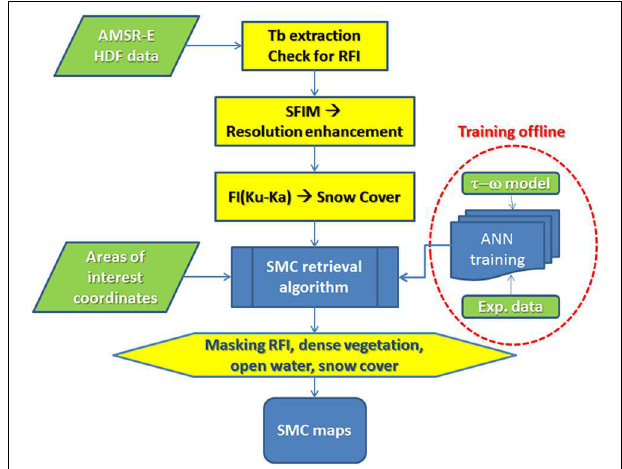
FIGURE 1 | Schematic representation of the HydroAlgo retrieval algorithm. HydroAlgo is based on an Artificial Neural Network (ANN) approach, where the training step is done using both in situ observed and simulated data. Soil moisture retrieval is carried out using C-band AMSR-E T B